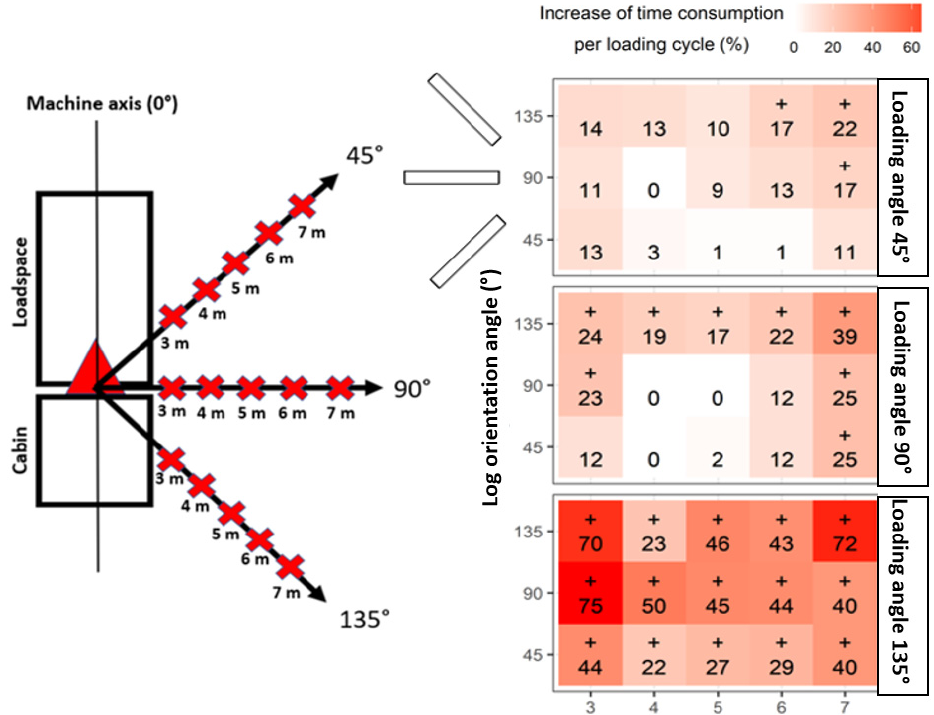
Figure 5. Relative increase of time consumption for loading cycles according to all test settings and reference value (‘0’).